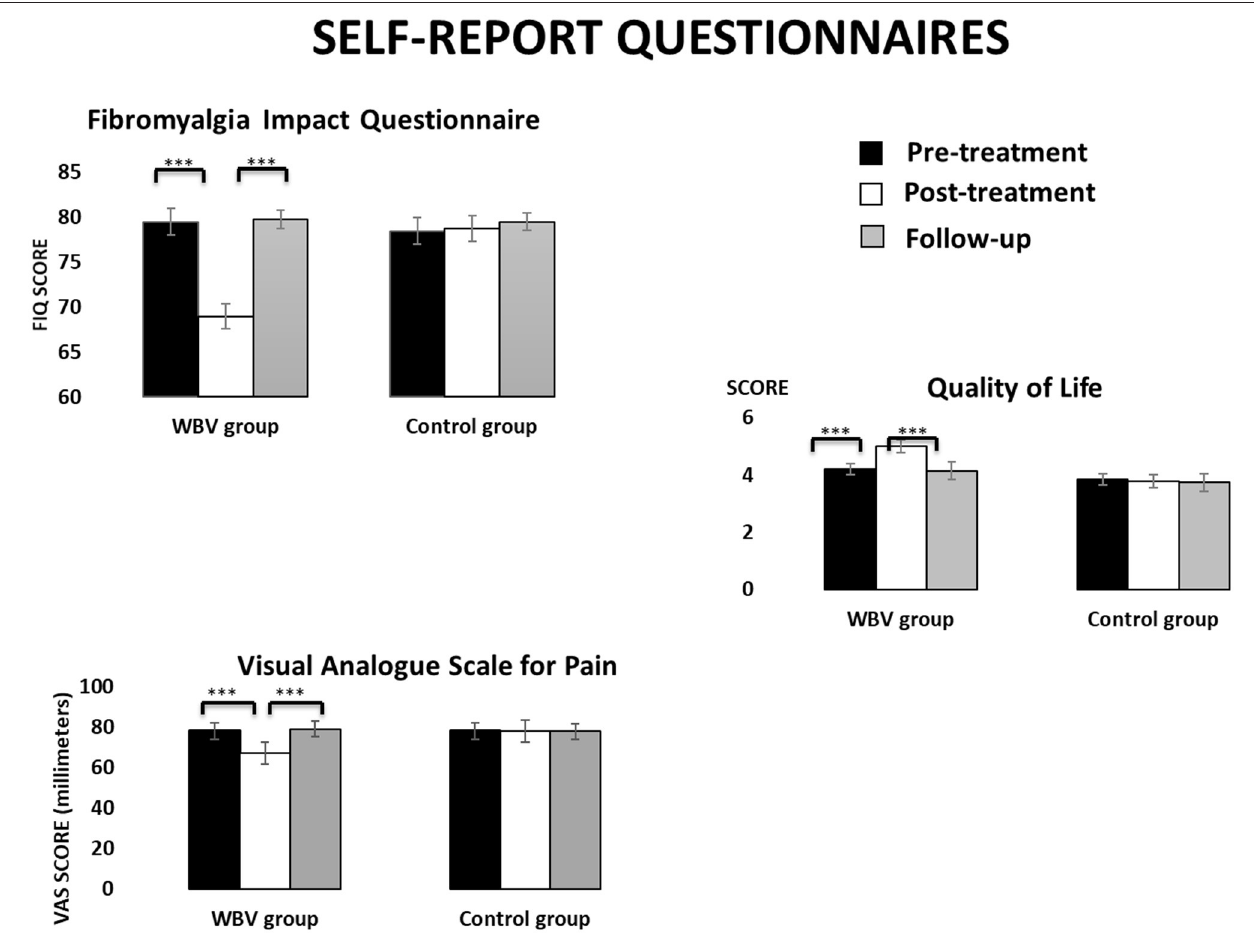
FIGURE 1 | Descriptive data (mean and TE) for the WBV group and the control group in self-report questionnaires at the three assessment